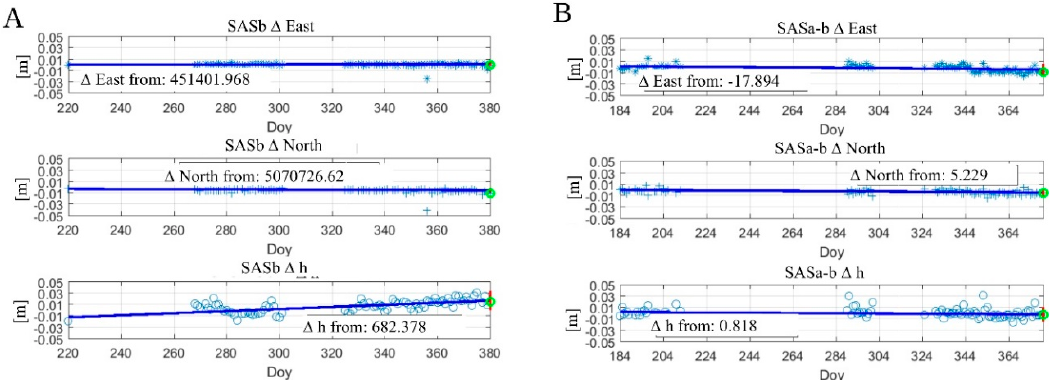
Figure 11. An example of displacement and deformation time series output sent to a monitoring expert. ( A ) computation of the E, N, and h displacements from the difference with original WGS84 32N coordinates for the GNSS SAS b; ( B ) computation of the deformation calculated from the original distance between the GNSS SAS a and SAS b. The time is expressed in Doy (Day of the year, where 0 is 1 January 2018).